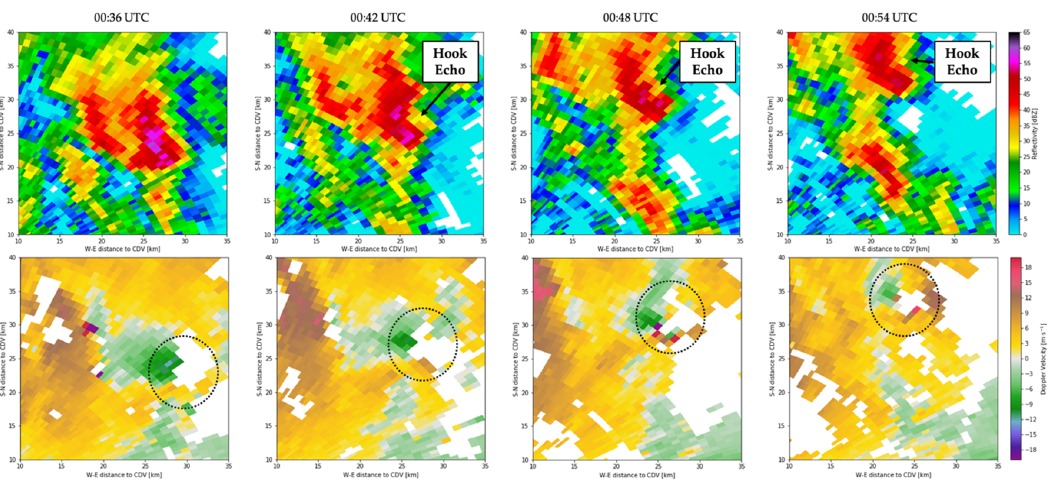
Figure 5. Raw CDV radar fields for the supercell case on 7 January 2018 at 2 ◦ elevation angle. Reflectivity (dBZ; upper panels) and dual-PRF outliers-corrected Doppler velocity (m·s −1 ; lower panels) at 00:36–00:54 UTC. Dashed circles indicate the areas with missing pixels.